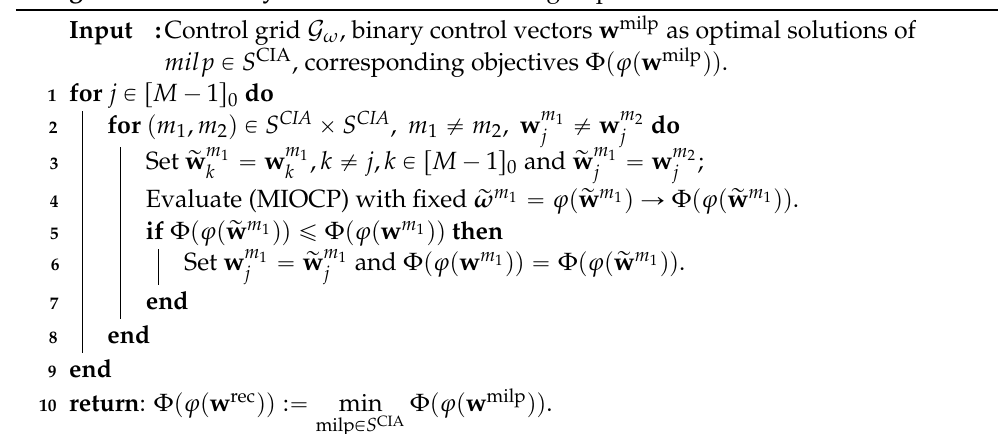
Algorithm 2: GreedyTime heuristic for finding improved w